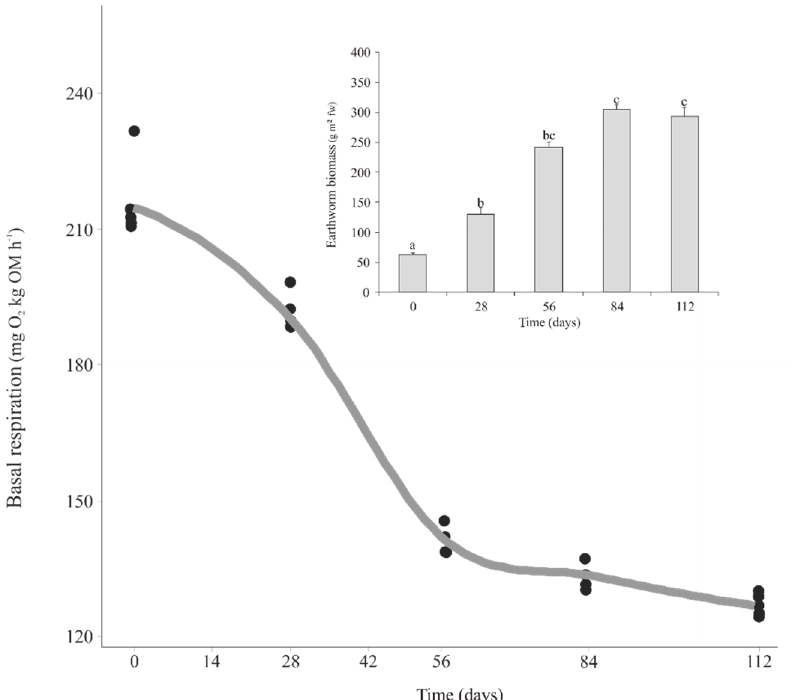
Figure 1. Changes in microbial activity measured as basal respiration during vermicomposting of grape marc derived from the red winemaking process of the grape variety Mencía. Individual values ( n = 5) are plotted for each time point, and the curve was plotted using the “loess” smoothing method in ggplot2 [46]. The inset shows changes in earthworm biomass during the process. Earthworm biomass values are presented as means ± standard error ( n = 5). Letters indicate significant differences between time points (Tukey HSD test).